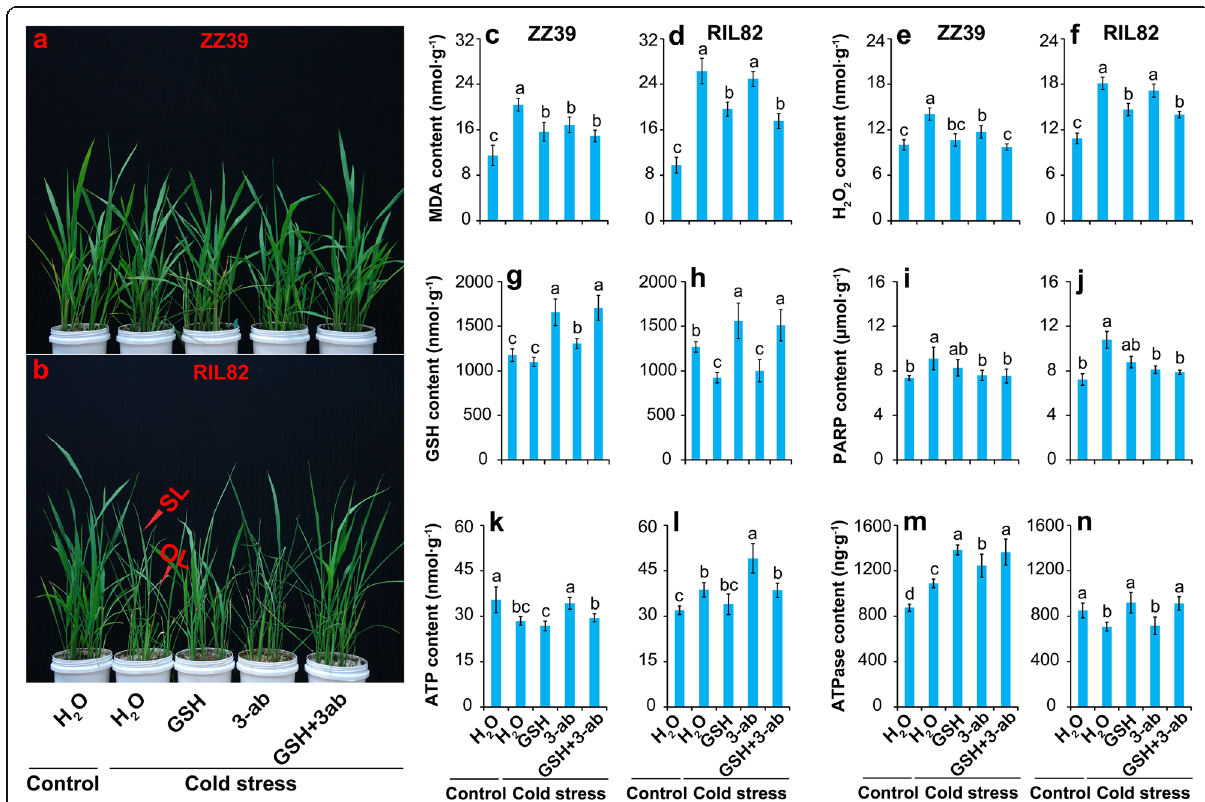
Fig. 9 Effects of GSH and 3-ab on leaf morphology and contents of MDA, H 2 O 2 , GSH, ATP, PARP and ATPase in rice leaves under cold stress. a and b The photos of leaf morphology; c and d , MDA; e and f , H 2 O 2 ; g and h , GSH; i and j , PARP; k and l , ATP; m and n , ATPase. GSH, Glutathione; 3-ab, 3-aminobenzamide; GSH, Glutathione; PARP, Poly (ADP-ribose) polymerase; SL, Second leaf; OL, Old leaf. Vertical bars denote standard deviations ( n = 3). Different letters indicate significant differences among the treatments under control and cold stress within a genotype by two-way analysis of variance for two factors (temperature and treatment) ( P <